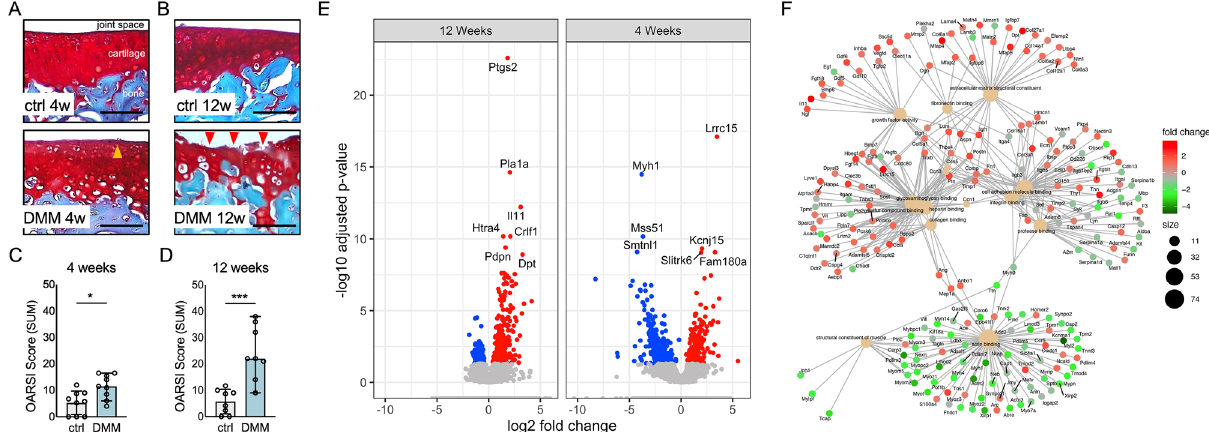
Figure 1. The progression of osteoarthritis after DMM is accompanied by transcriptional changes in articular cartilage. Representative Safranin O-stained histological sections of mouse cartilage at ( A ) 4 and ( B ) 12 weeks after surgical induction of OA (original magnification × 20, scale bar = 50 μm). Arrowheads indicate areas of proteoglycan depletion and minor fibrillation (orange, 4 weeks), or loss of surface and structural damage (red, 12 weeks). Graphs represent the OARSI (SUM) cartilage degradation scores for ( C ) 4 (n = 9/ea) and ( D ) 12 (n = 8/ea) weeks. *p < 0.05 and ***p < 0.001 by Mann–Whitney. ( E ) Volcano plot representing significantly differentially expressed genes (adjusted p-value < 0.05) identified by RNA-seq analyses of microdissected cartilage tissues retrieved at 4 and 12 weeks after DMM surgery (n = 3 per condition and per time point). Log fold-changes in the OA (DMM operated) vs. control limbs are shown for each time point. Red indicates high expression in the OA samples. Blue indicates high expression in the control samples. ( F ) A gene concept network of functional enrichment showing genes with increased (red) and decreased (green) expression in OA cartilage from top enriched functions in cartilage tissues after surgical induction of